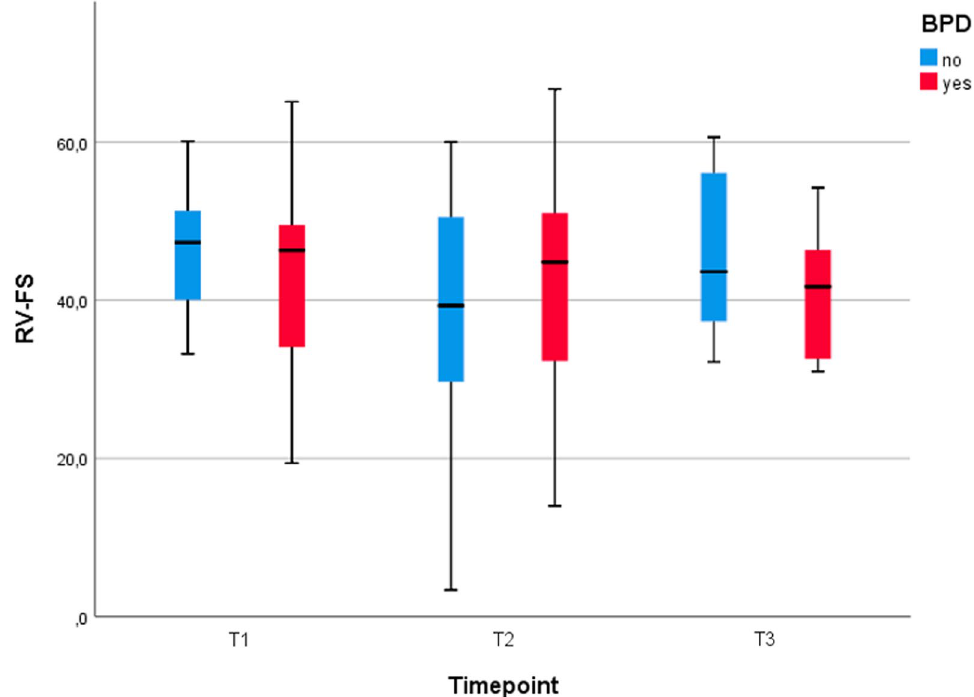
Fig. 4 RV‑FS (mean and standard deviation) at different timepoints. No clear changes in RV‑FS can be seen with time in either group (BPD or NO‑BPD